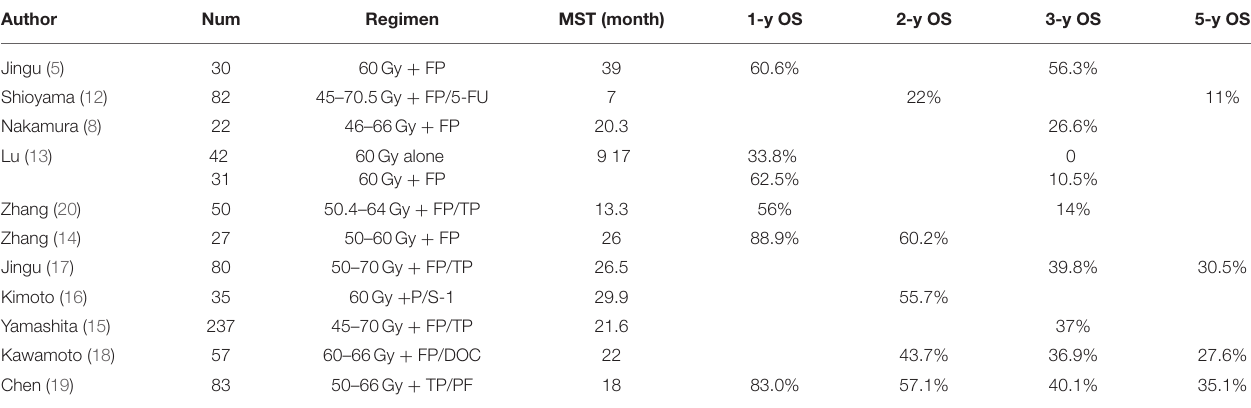
TABLE 4 | Previous studies on salvage RT with lymph node